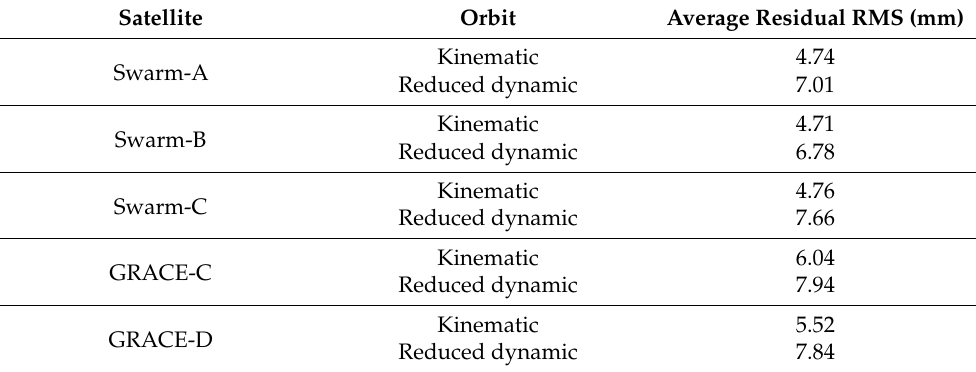
Figure 2. RMS of the phase observation residuals: ( a ) Swarm-A; ( b ) Swarm-B; ( c ) Swarm-C; ( d ) GRACE-C; and ( e ) GRACE-D, where white blocks and black blocks in ( a – e ) mean the RMS of the kinematic orbit and reduced dynamic orbit on each day, respectively. The diamond-shaped lines show the solar flux index F10.7 for each day (unit: 10 − 22 W/m 2 /Hz ) . Table 2. All satellites’ average RMS of the residuals for all phase observations.